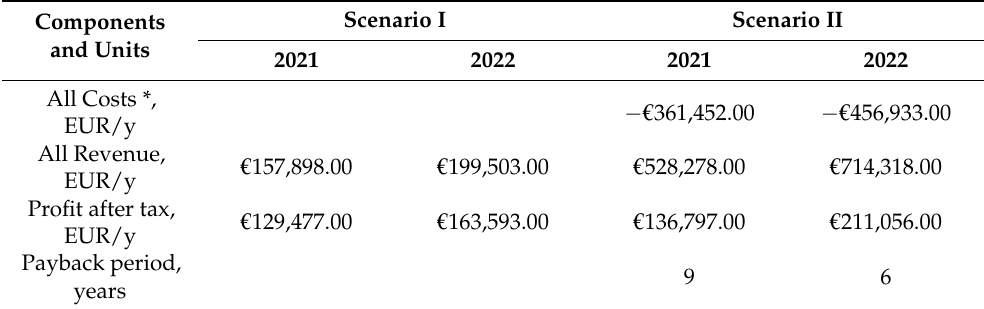
Table 9. Economic balance for Scenarios I and II in years